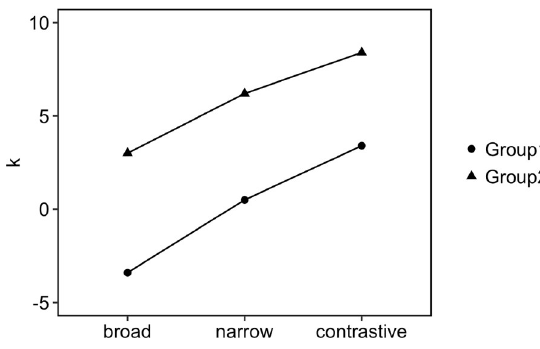
Fig 21. Control parameter values (k) of the two speaker